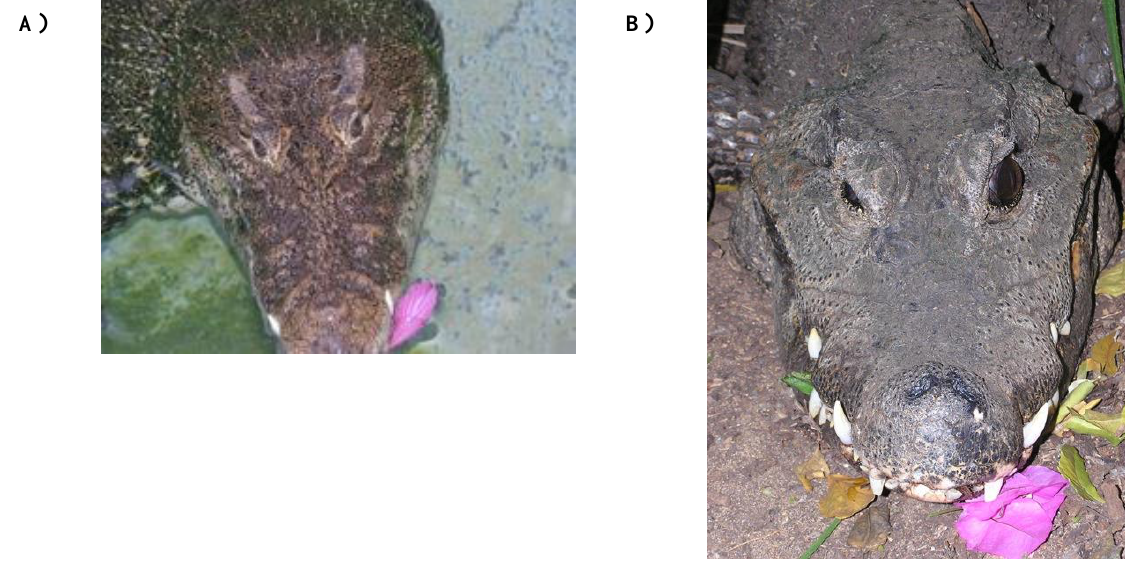
Figure 2. Crocodiles playing with Bougainvillea flowers. A) Cuban crocodile ( Crocodylus rhombifer ) in Zoo Miami, Florida, USA. B) West African dwarf crocodile ( Osteolaemus cf. tetraspis ), Madras Crocodile Bank, Tamil Nadu,